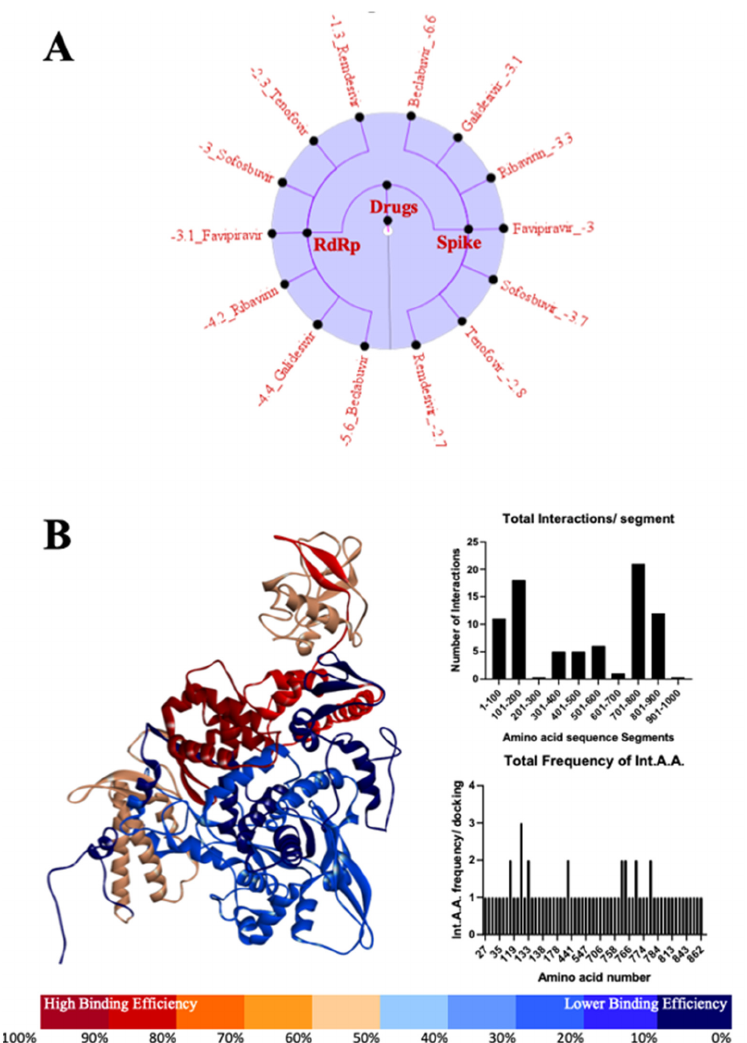
Figure 6. A graphical representation of the comparative analysis found in Table S4. Binding energies are organized here ( A ) and are arranged from weakest to strongest based on the molecule they are interacting with. These lists of drugs and their binding energies are separated along the central axis based on the viral protein they are interacting with, namely RdRp on the left and the Spike protein on the right-hand side. Additionally, quantitative analysis and graphical representation of the locations at which the molecules are interacting with the SARS-CoV-2 RdRp ( B ) can be observed.